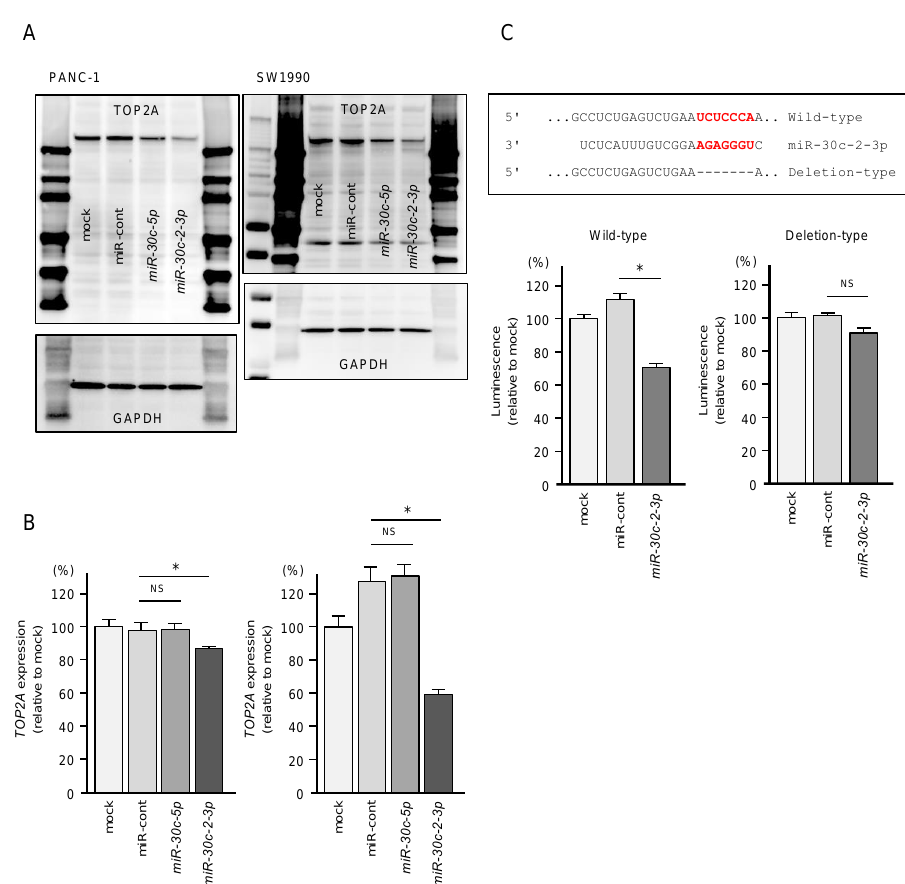
Figure 6. Direct regulation of TOP2A by miR-30c-2-3p in PDAC cells. ( A ) Protein expression levels of TOP2A were significantly reduced by miR-30c-2-3p transfection into PANC-1 and SW1990 cells (72 h after transfection). Images of whole Western blot gels are shown. GAPDH was used as an internal control. ( B ) mRNA expression levels of TOP2A were significantly reduced by miR-30c-2-3p transfection into PANC-1 and SW1990 cells. ( C ) TargetScan database analysis showed that one putative binding site of miR-30c-2-3p was annotated in the 3′-UTR region of TOP2A . Dual-luciferase reporter assays showed that luminescence activity was reduced by co-transfection with wild-type vector (containing miR-30c-2-3p binding sites) and miR-30c-2-3p in PANC-1 cells. Normalized data were calculated as the ratios of Renilla/firefly luciferase activity.